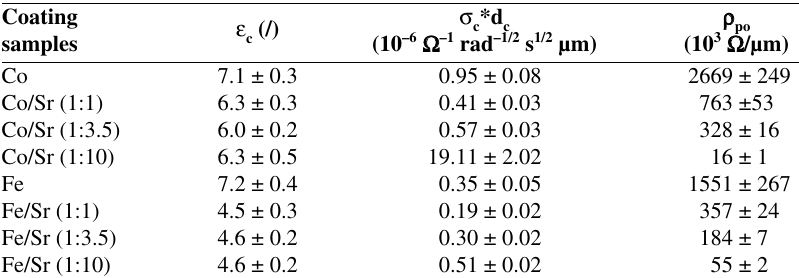
Table 3. EIS parameters after 4 h after exposure in the humidity chamber. Coating